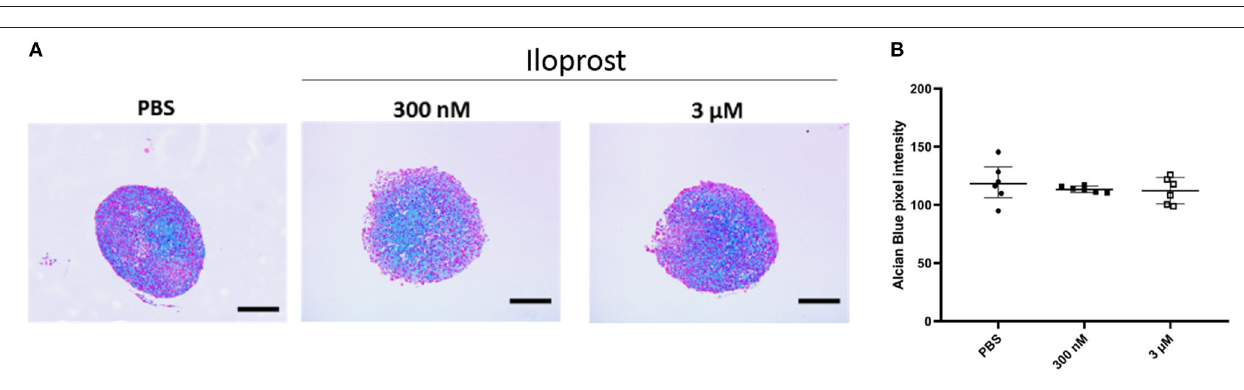
(Iloprost), indicated by a red color after Movat’s Pentachrome staining ( Figure 10A , left). After 21 days, no fibrin scaffold was detected anymore in or around the osteotomy area ( Figure 10A , right). Histomorphometrical analysis of the tissue distribution revealed a significantly higher amount